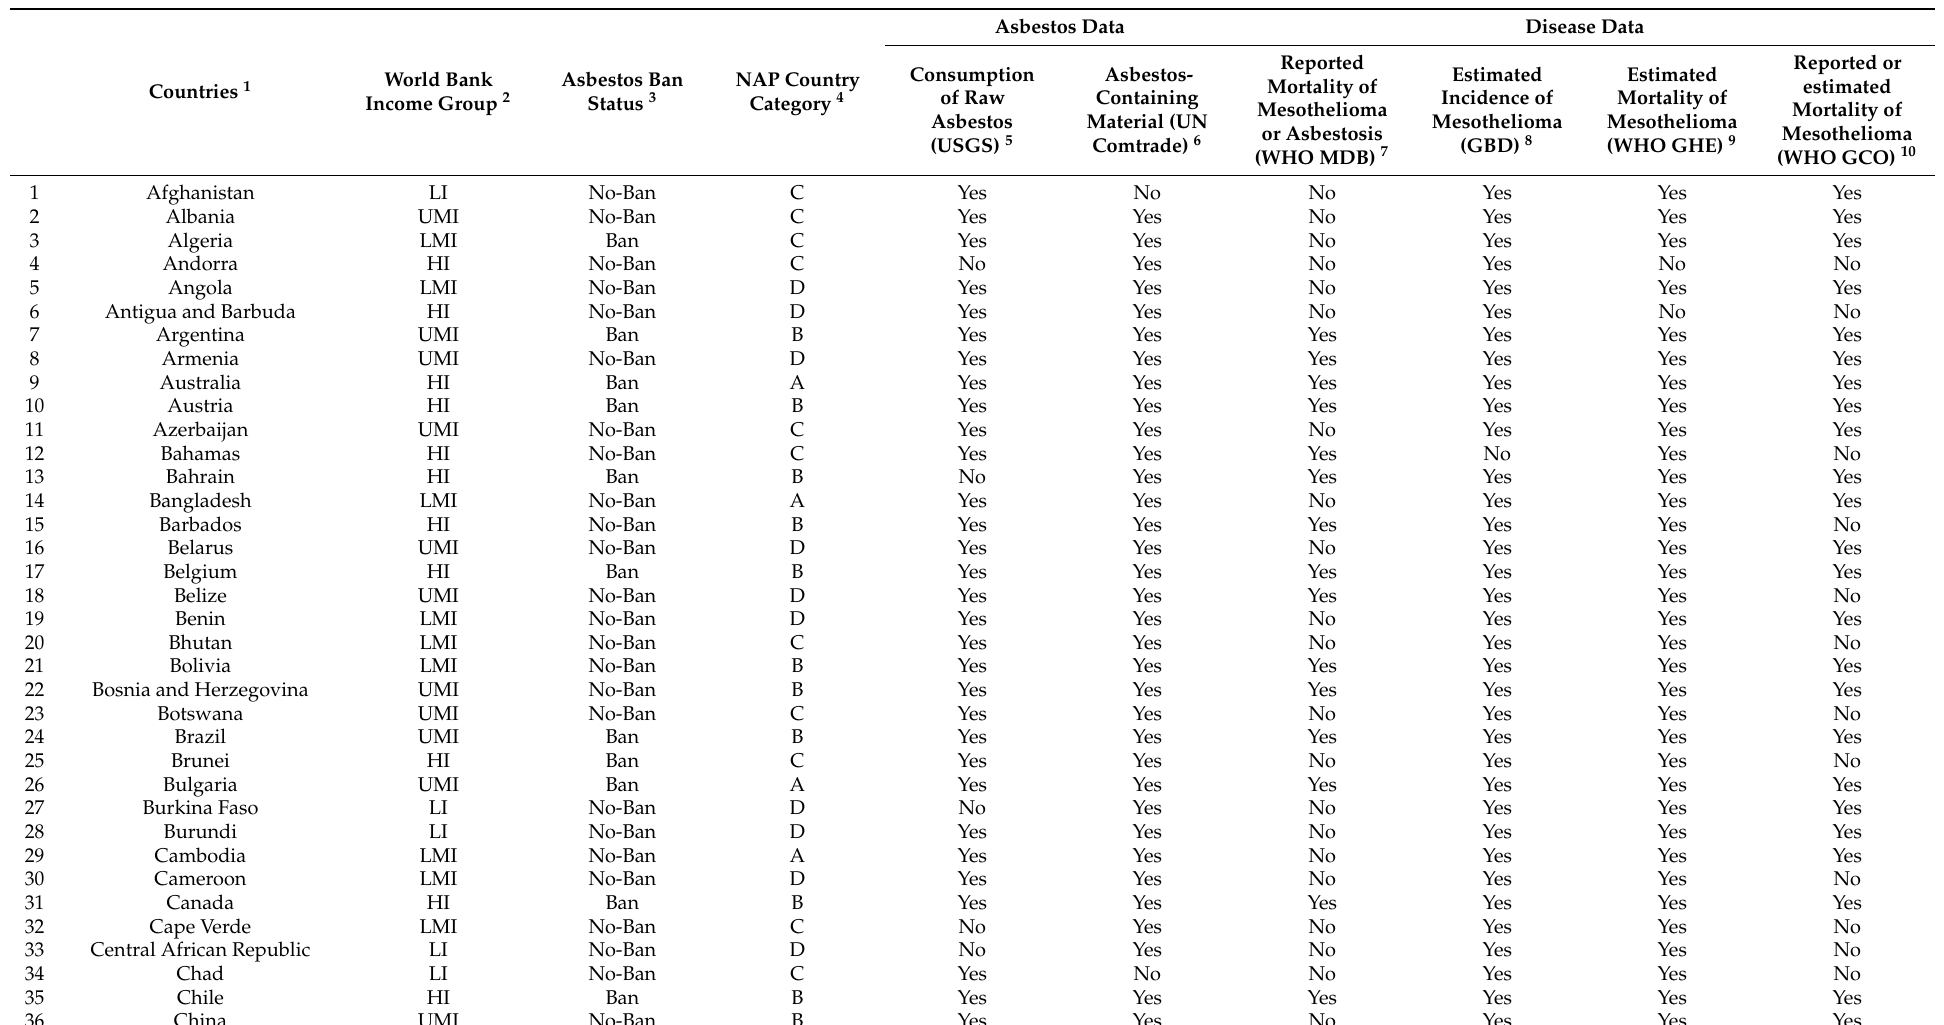
Table A2. Availability of Asbestos and Asbestos-Related-Diseases Data by Country and NAP Country